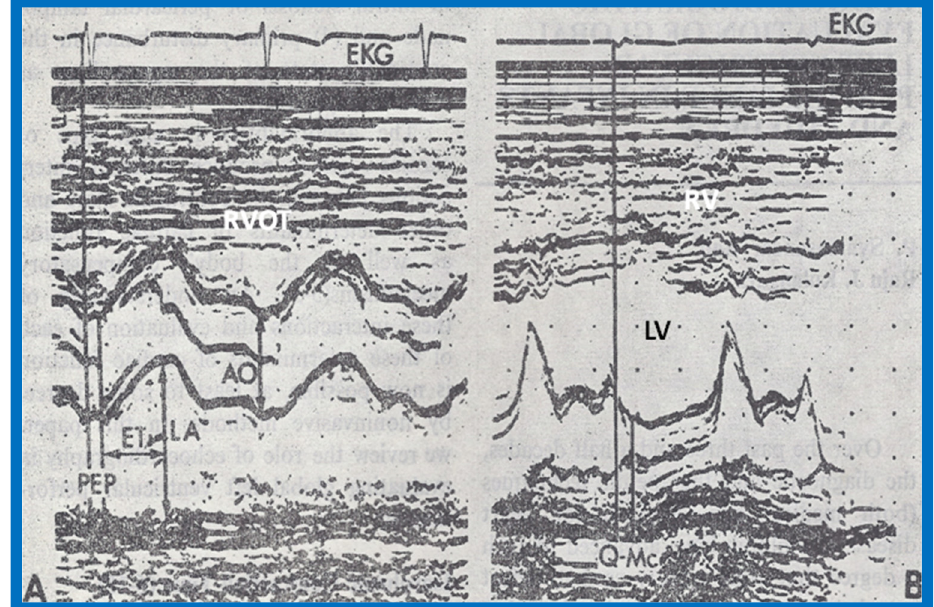
Figure 12. (A ) Selected M-mode recordings from the parasternal short axis view of the left atrium (LA), aorta (Ao), and right ventricular outflow tract (RVOT) illustrating measurements of preejection period (PEP) and ejection time (ET). ( B ) Selected M-mode recordings from the parasternal short axis view of the left ventricle (LV) and right ventricle (RV) showing mitral valve closure and Q-Mc (Q wave of the electrocardiogram (EKG) to mitral valve closure). Isovolumic contraction time (ICT) is calculated by subtracting Q-Mc from PEP, ensuring that both recordings are made from cardiac cycles of identical length. Modified from Rao P.S., Kulangara R.J.